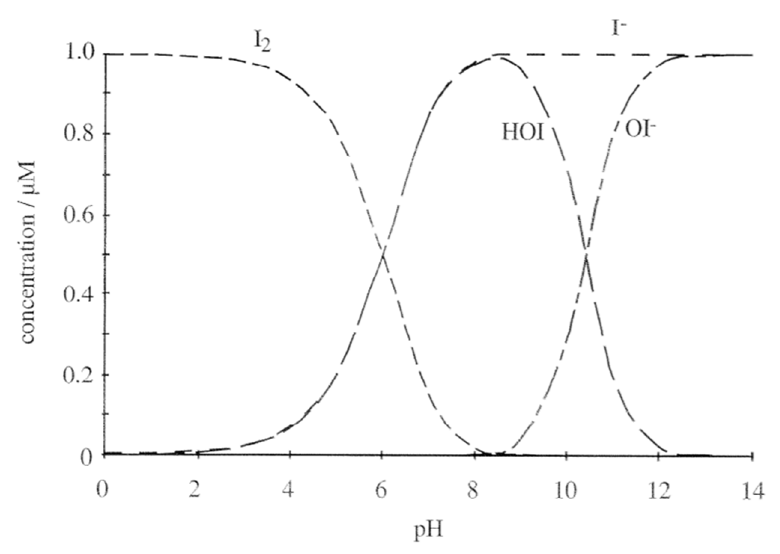
Figure 8. pH-dependent speciation of iodine [51].